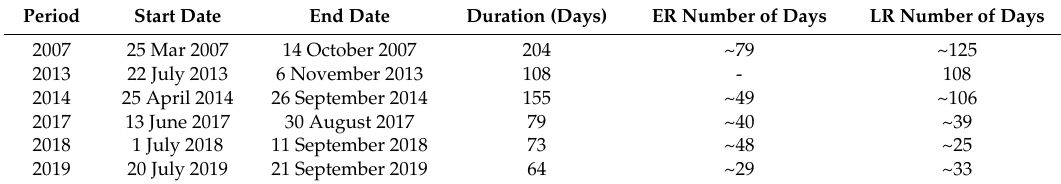
Table 2. Agios Georgios station tidal analysis flow recession selected periods.